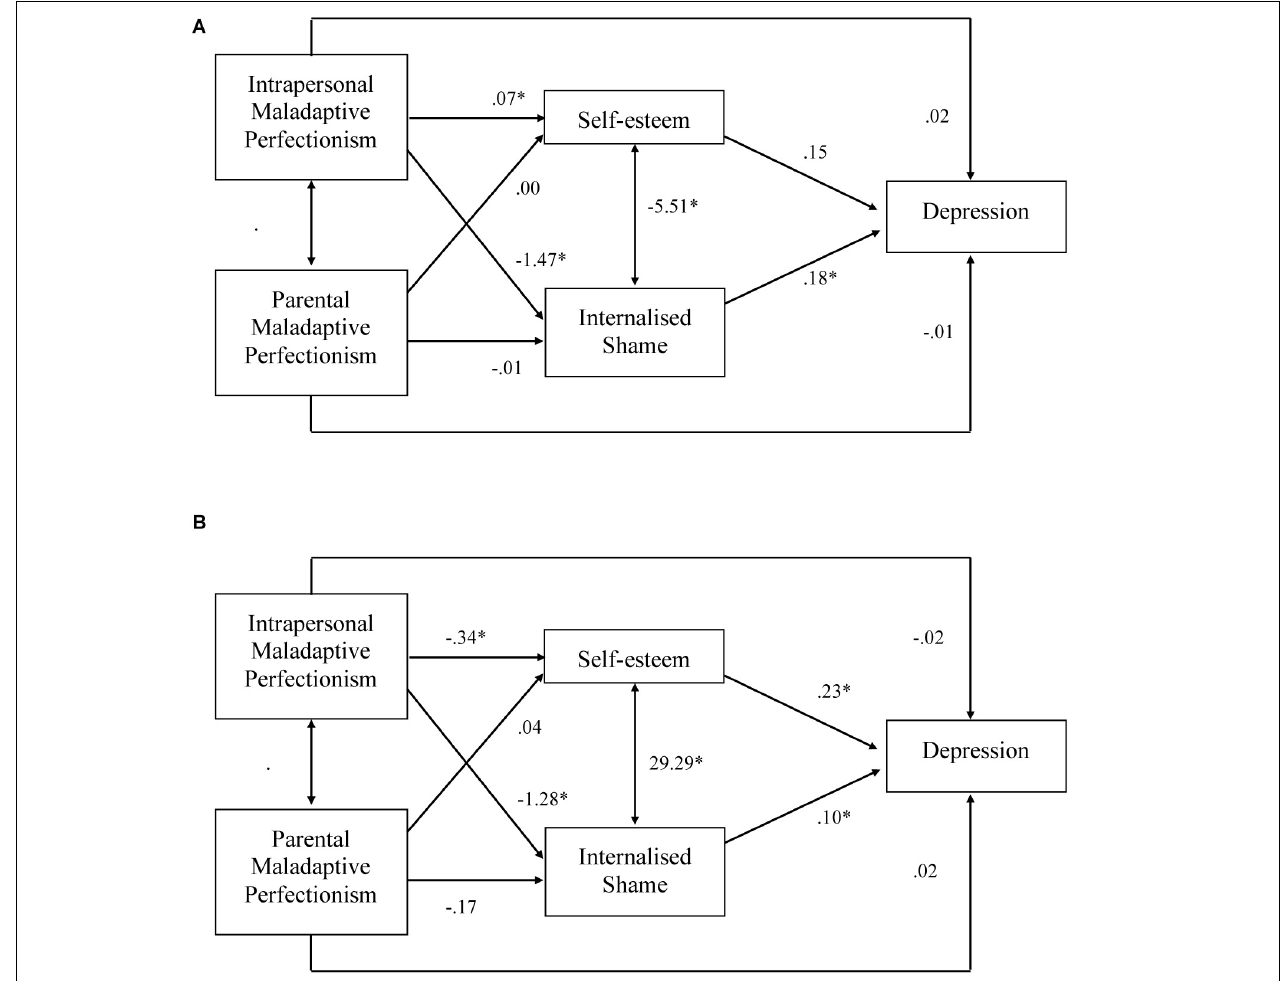
FIGURE 1 | (A) Path model for Australian domestic sample. (B) Path model for Asian international